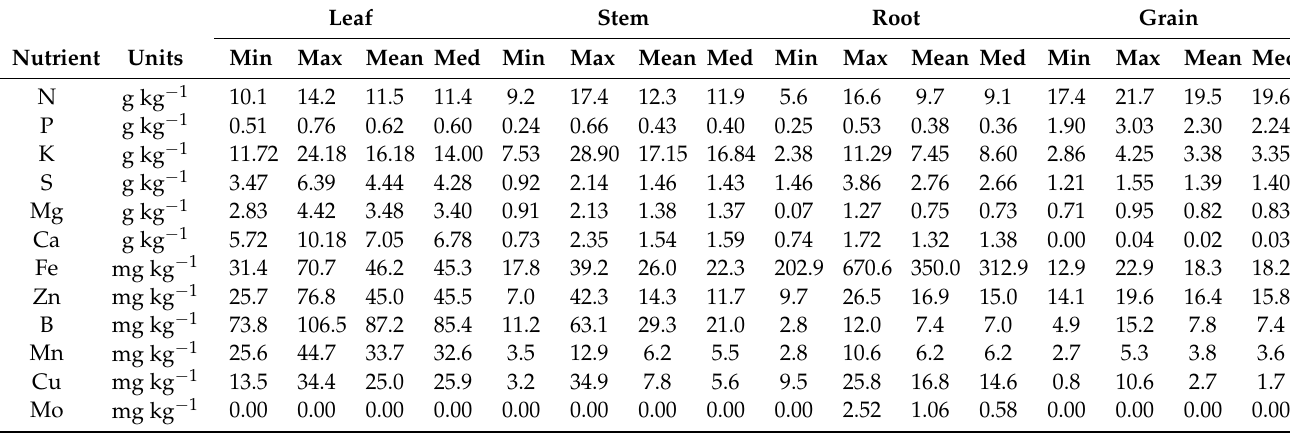
Table 4. Nutrient concentrations in leaf, stem, root, and grain from harvested maize plants grown synthetically in the indoor grow room during a fertility trial. Values represent averages among three replications and three different hybrids grown using a concentration of 8 mg P L − 1 in fertigation solution. Leaf Stem Root Grain